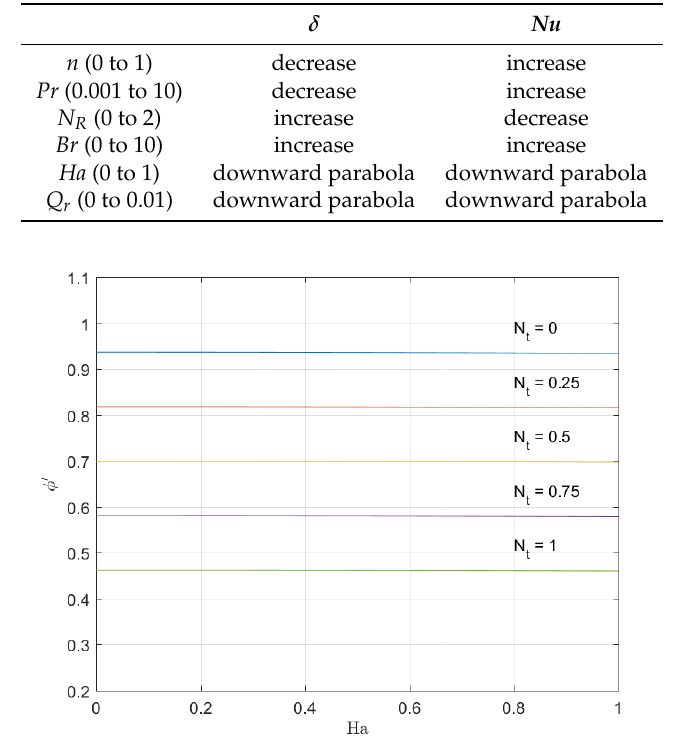
Table 4. Parameter effects on heat transfer and boundary-layer characteristics.